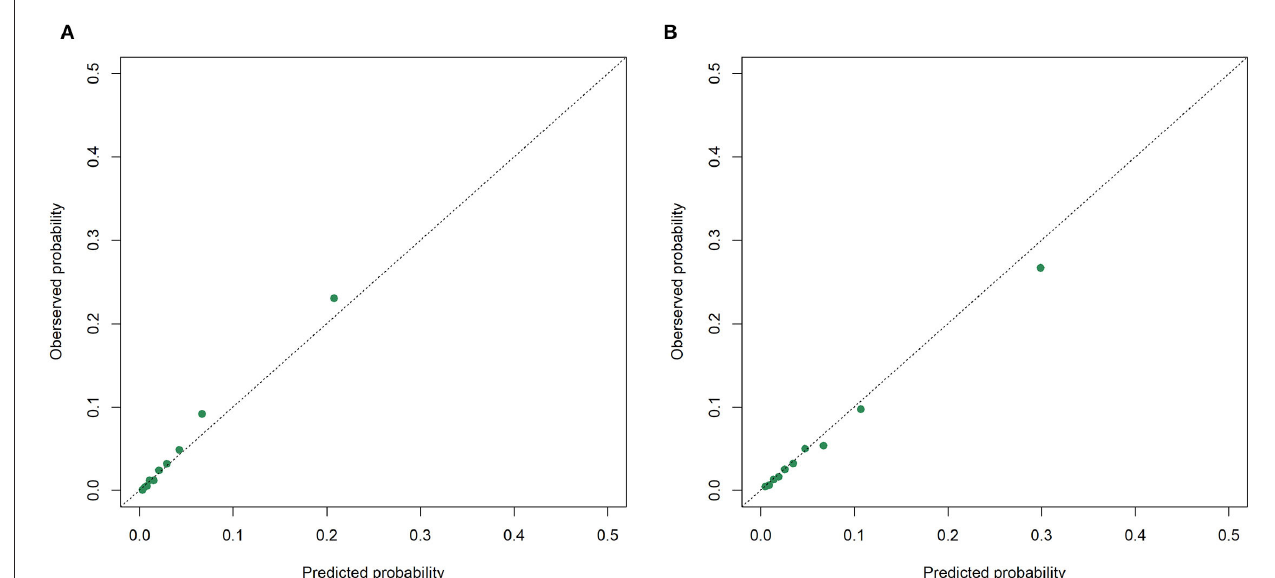
FIGURE 3 | Calibration curves of the XGBoost model for mortality in the following 48h in the internal. (A) and the external; (B) test sets.